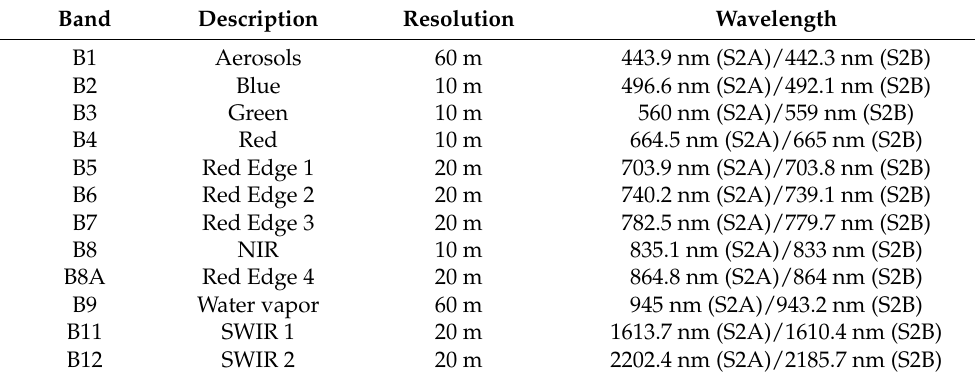
Table 1. Characteristics of Sentinel-2 MSI L2A